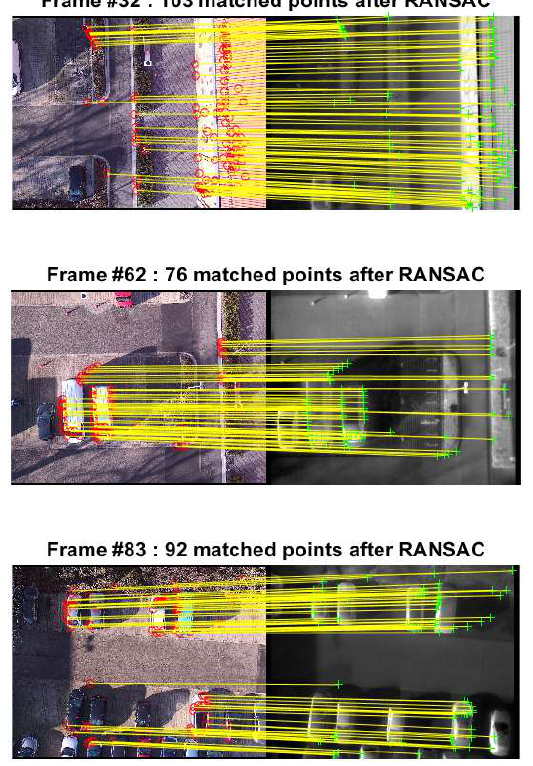
Figure 8. Examples of multimodal